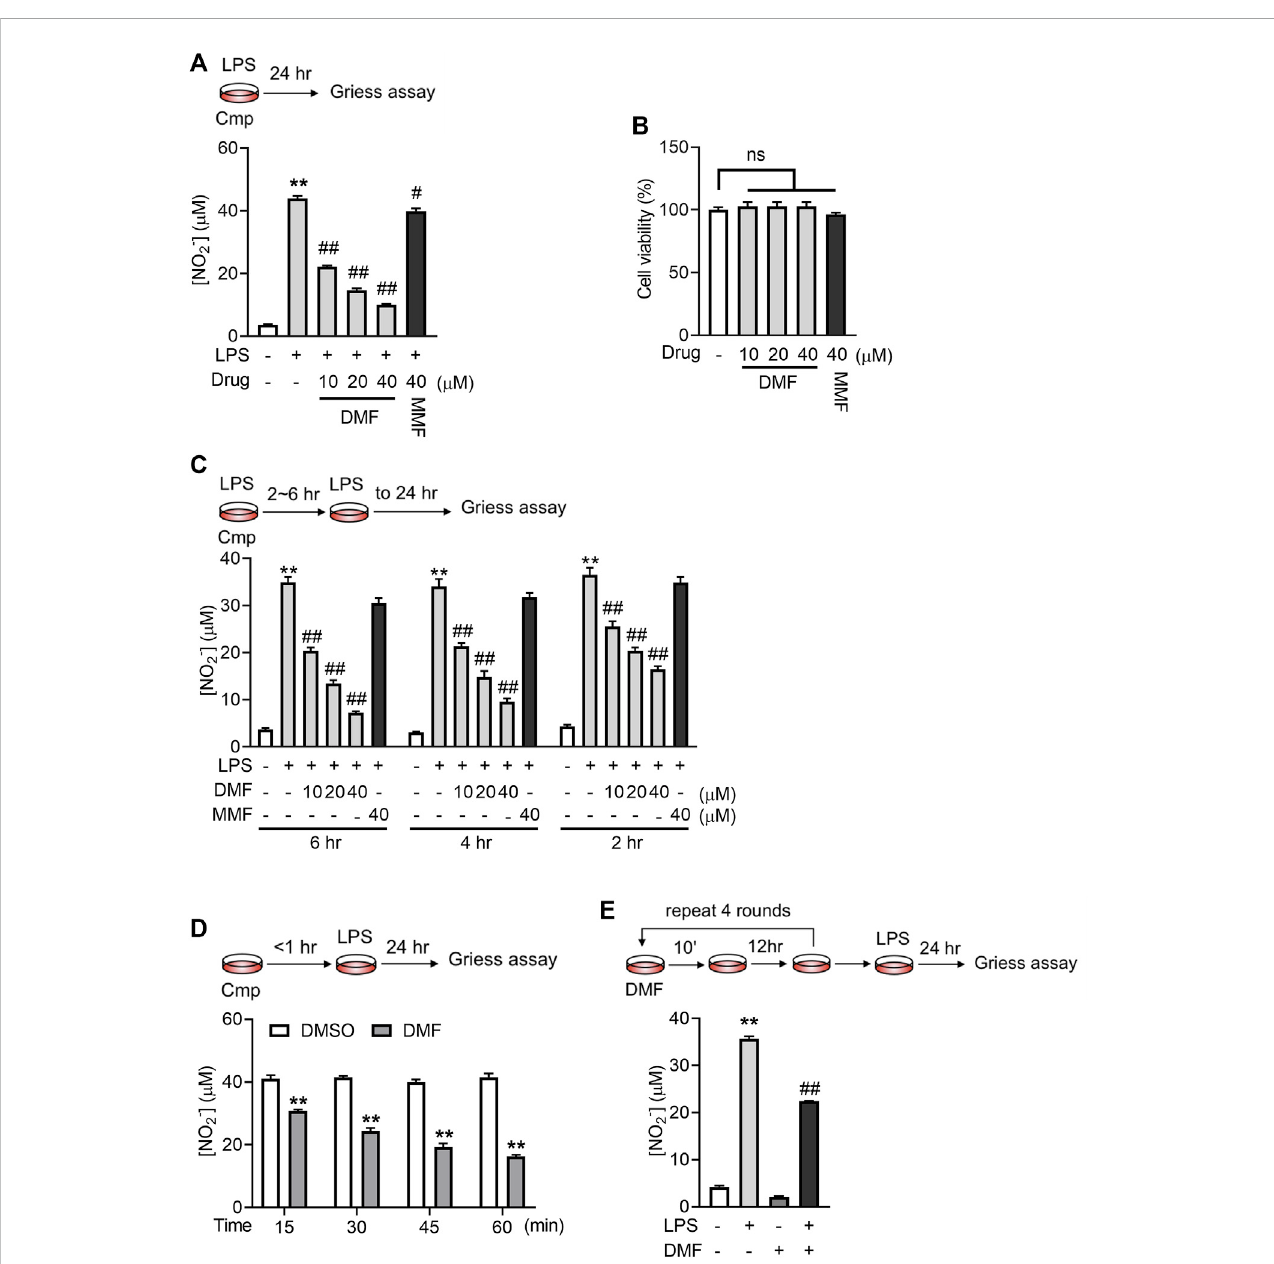
FIGURE 1 Short-term exposure to DMF inhibited LPS-mediated activation of RAW264.7 cells. (A) RAW264.7cells weretreated with 1 μ g/mL LPS in thepresence or absence of DMF/MMF for 24 h, and nitrite production in the indicated groups was quanti fi ed by the Griess assay ( n = 3). (B) RAW264.7 cells were treated with DMF or MMF for 24 h, and the cell viability of the indicated groups was determined by MTT assay ( n = 3). (C) RAW264.7 cells were treated with 1 μ g/mL LPS in the presence or absenceof DMF/MMF for 2 – 6 h and then cultured in medium with LPS only for a total of 24 h. The nitrite productionfrom theindicated groups was quanti fi ed by the Griess assay ( n = 3). (D) RAW264.7 cells were exposed to 40 μ M DMF for 15 – 60 min and then cultured in medium with LPS only for24 h.Thenitriteproductionfromtheindicatedgroupswasquanti fi edbytheGriessassay( n =3). (E) Raw264.7cellsweretransientlyexposedto10 μ